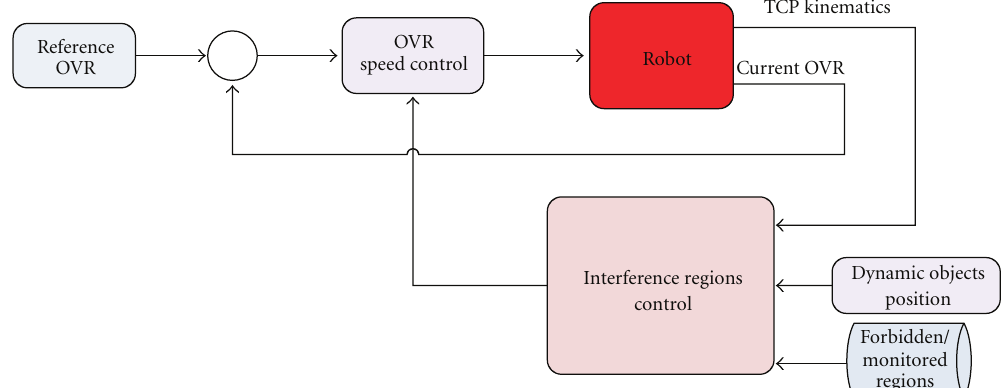
Figure 1: Interference Regions Control